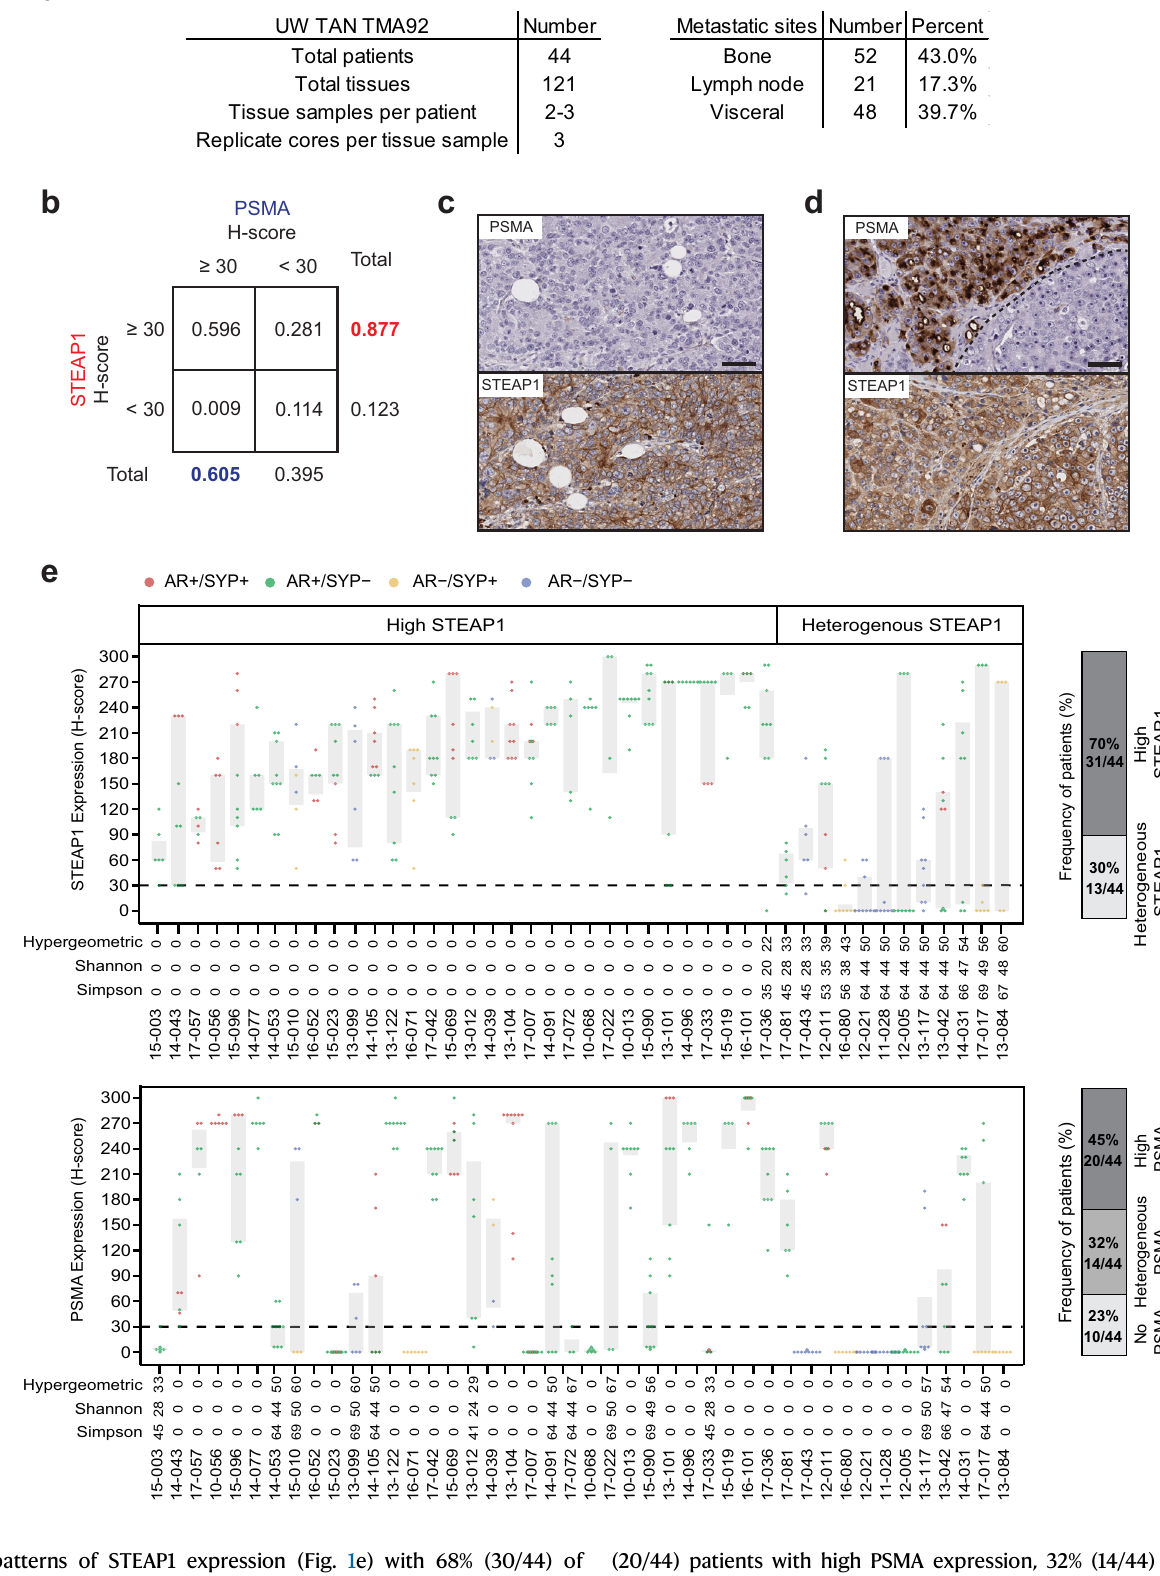
(20/44) patients with high PSMA expression, 32% (14/44) with het- erogeneous PSMA expression, and 23% (10/44) with no PSMA expres- sion. Based on molecular subclassi fi cation of mCRPC tissues using AR and the neuroendocrine marker synaptophysin (SYP) expression assessed by IHC, most patients with high or heterogeneous STEAP1 and PSMA expression had AR-positive prostate cancer (AR+/SYP-